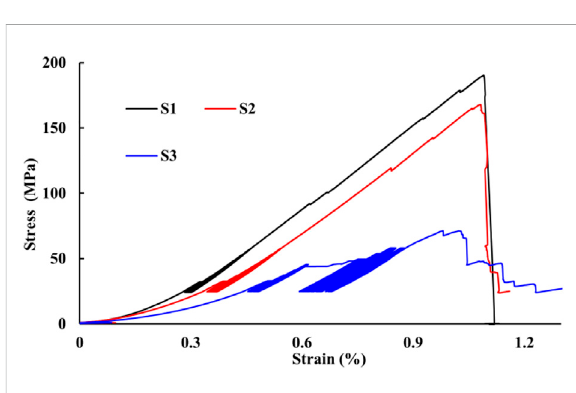
FIGURE 7 Stress-strain curve of granite samples under different freeze- thaw